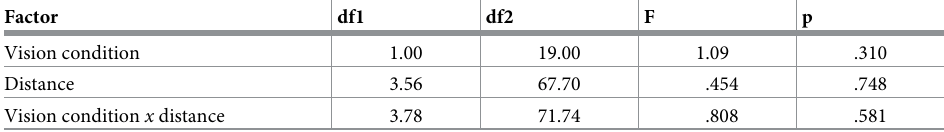
Fig 11. Variable error. Mean and standard deviation of the variable error of predicted putting distance under full (F-RCHB) and incomplete (I-RCHB) vision condition. https://doi.org/10.1371/journal.pone.0249518.g011 Table 8. Results of the two-factor ANOVA with repeated measures (6 distances; 2 vision conditions) for the vari- able error of the predicted putt length. Corrected by Greenhouse-Geisser � .